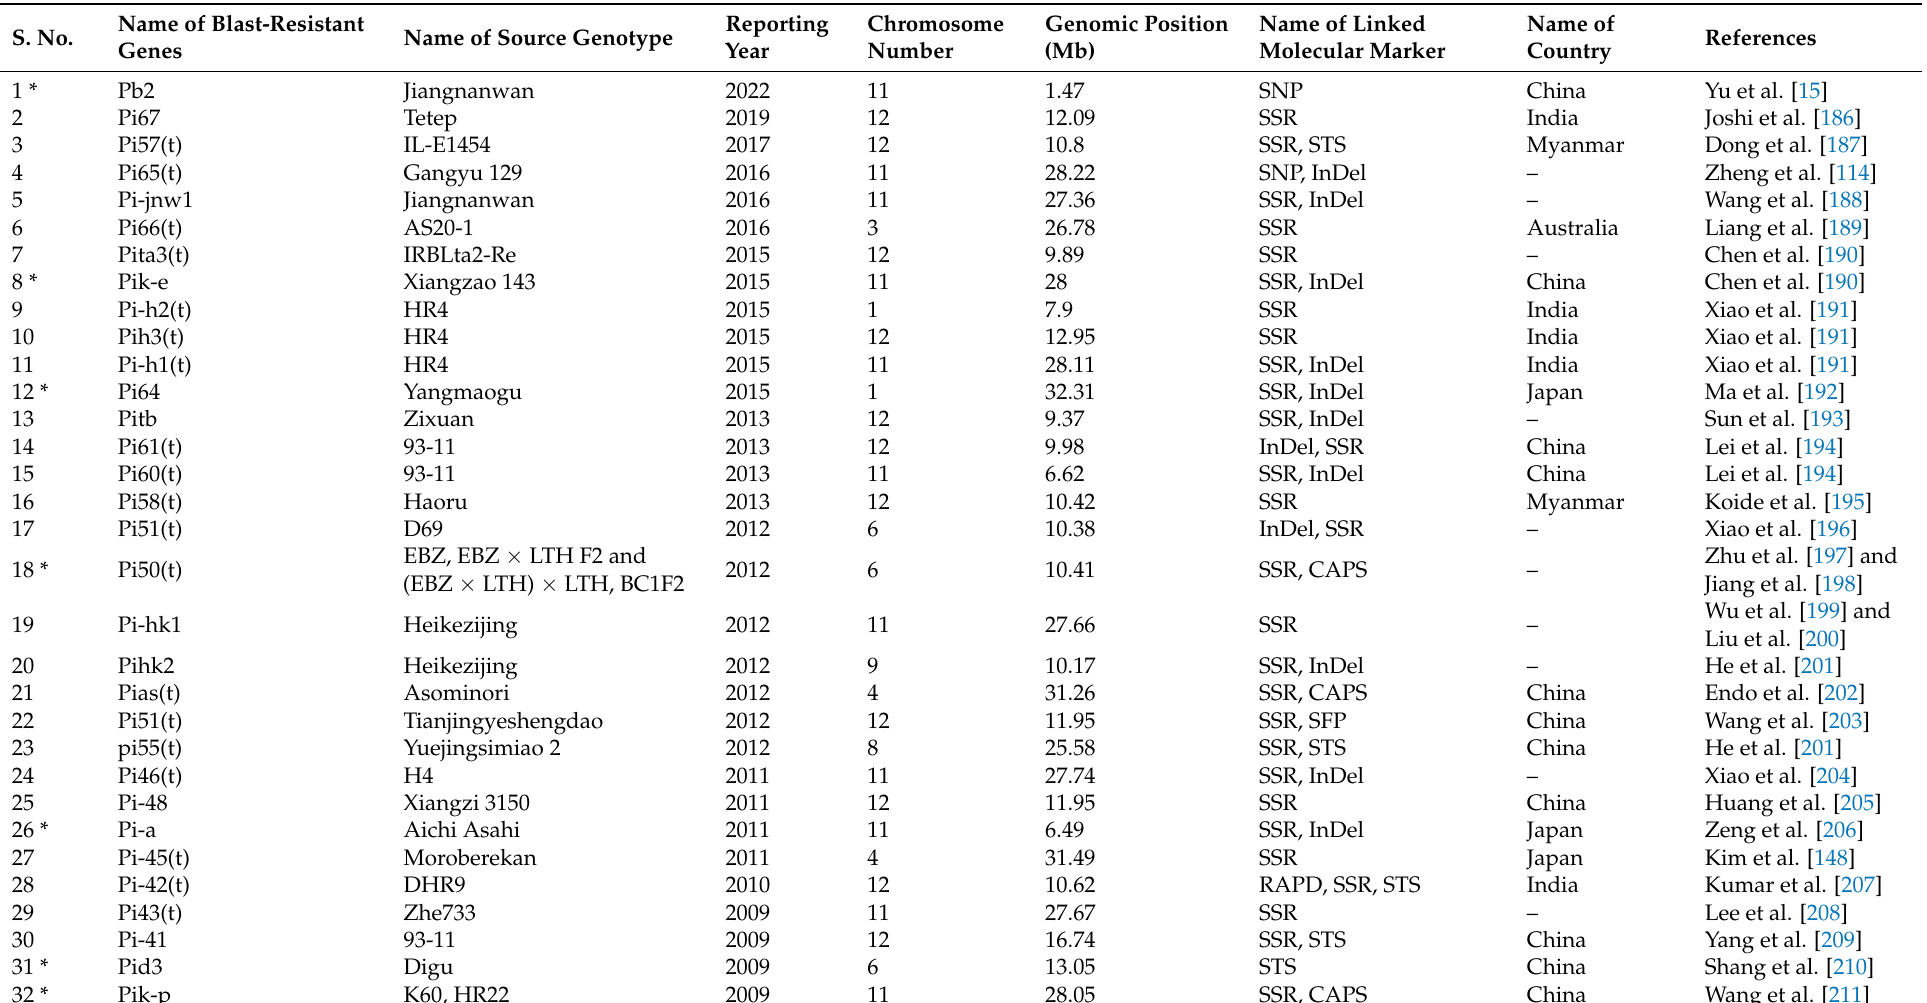
Table 2. List of 146 blast-resistant genes identified and mapped in